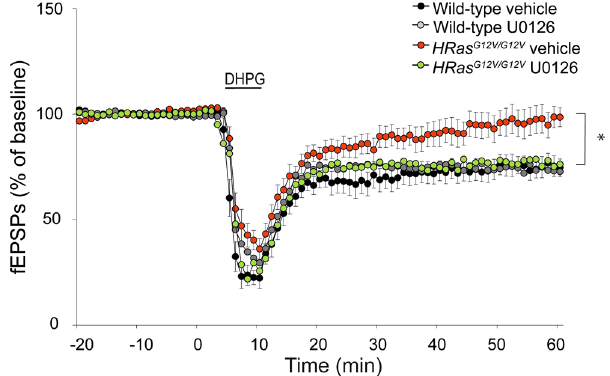
Figure 7. Acute inhibition of MEK rescues deficit in mGluR-LTD in HRas G12V/G12V mice. Induction of chemical LTD by application of DHPG for 5 min (50 μ M), induced stable depression of synaptic efficacy in slices of WT and only temporarily depression in HRas G12V/G12V slices, both treated with vehicle solution (effect of genotype, vehicle treated group: F 3,63 = 8.53, P < 0.01). Pre-incubation of slices with a MEK-inhibitor, U0126, did not affect wild-type LTD (wild-type vehicle vs. wild-type treated, P > 0.05), but rescued the LTD-deficit in HRas G12V/ G12V (wild-type treated vs. HRas G12V/G12V treated, p < 0.05). Data are presented as mean ± SEM from vehicle treated wild-type. Vehicle treated: wild-type n = 17 slices/5 mice, HRas G12V/G12V n = 17 slices/5 mice and drug treated: wild-type n = 16 slices/4 mice, HRas G12V/G12V n = 20 slices/5 mice. Statistical test: repeated measure ANOVA and post-hoc Bonferroni